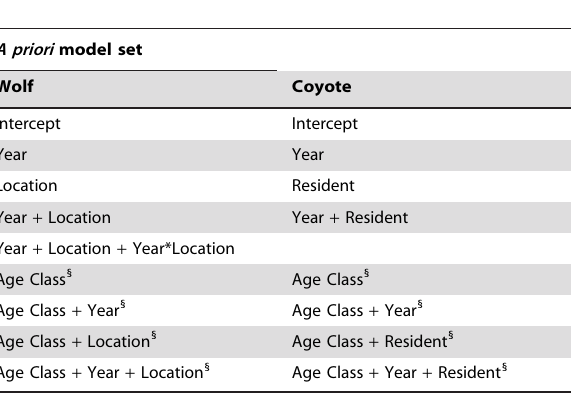
Table 2. A priori models of risk factors for canid pathogen exposure in Yellowstone National Park,